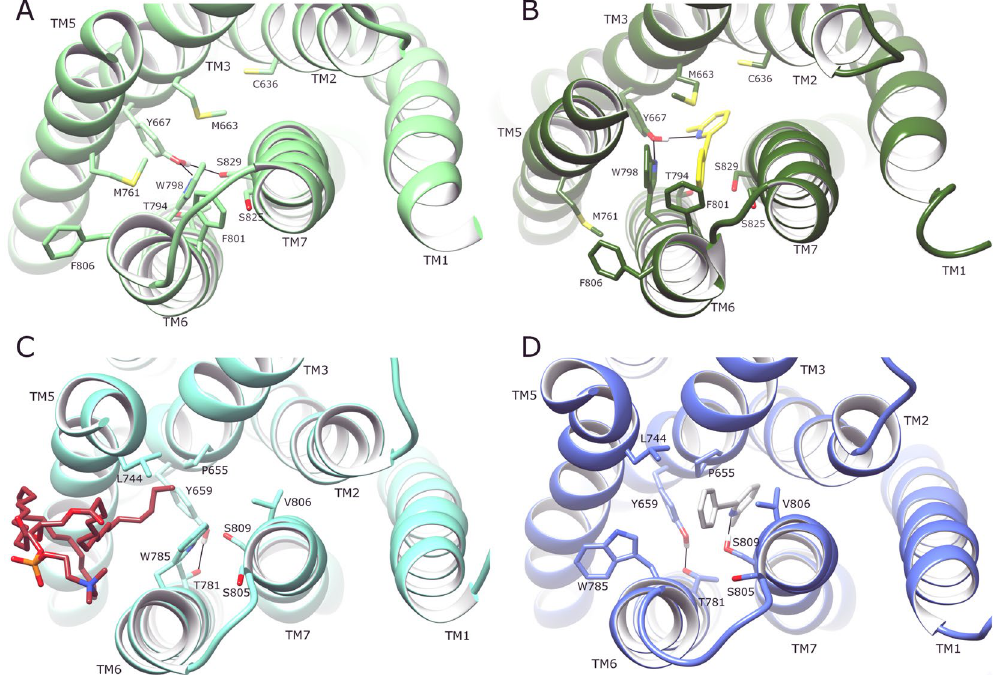
Figure 8. Comparison of average conformations of ( A ) apo mGlu4 without MPEP (light green), ( B ) mGlu4 with bound MPEP (dark green, yellow, respectively), ( C ) apo mGlu5 without MPEP (cyan) with bound lipid molecule (brown), ( D ) mGlu5 with bound MPEP (blue, light grey, respectively), each obtained from 2.5–5 µ s of respective MD simulations. Receptors are viewed extracellular-side from top. Relevant structural features are labelled, i.e. transmembrane helices (TMs) and residues in the allosteric pocket interacting with